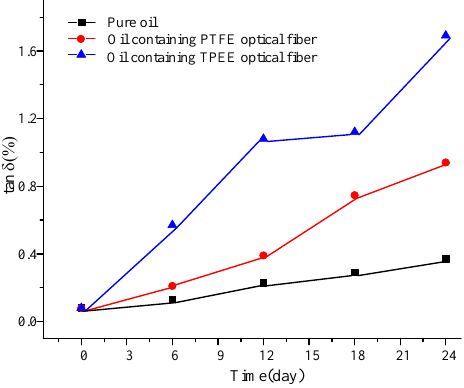
Figure 1. The dielectric dissipation factor (DDF) of oil. PTFE is poly tetra fluoroethylene; TPEE is thermoplastic polyester elastomer.